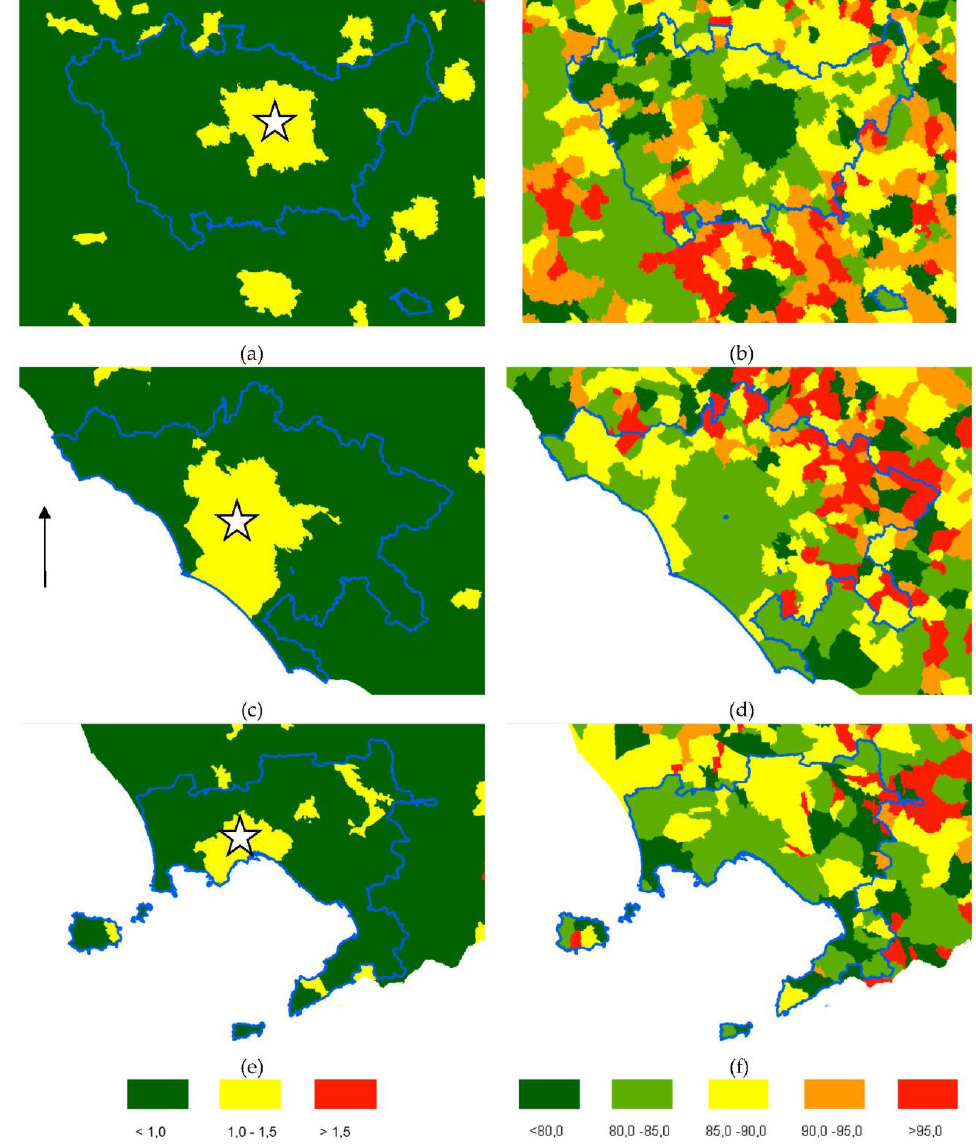
Figure 2. Centrality index (left) and percent share of population living in peripheral settings (Section 3.2) in total population, calculated following Istat framework (Milan: upper panel; Rome: intermediate panel; and Naples: lower panel); arrow indicates the North; stars indicate the municipalities of Milan, Rome, and Naples. While maintaining the national coverage, the present works generalized the ap- proach described in Section 3.2 at the enumeration district level (more than 400,000 units for Italy) with the aim of emphasizing the local dimension of urban centrality, highlight- ing changes in the spatial distribution of the population as far as residence and job place are jointly concerned [10]. When working with enumeration district data, however, values